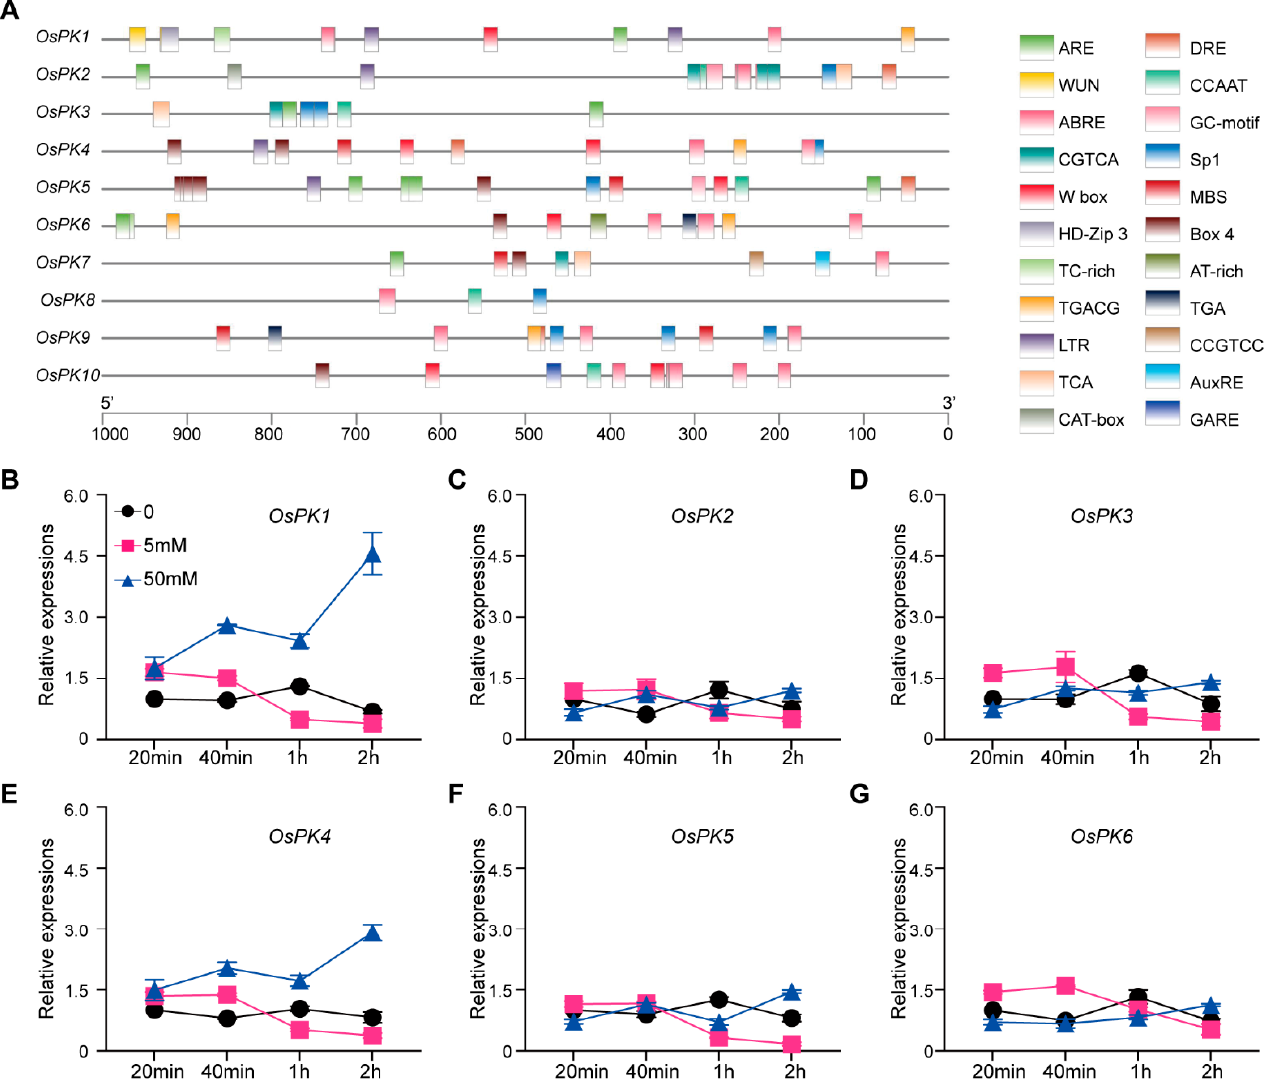
Figure 5. Prediction of promoter element of PK genes in rice and PK gene responses to abscisic ac- id. ( A ) ARE is a cis -acting regulatory element that is essential for anaerobic induction. MBS is an MYB binding site that is involved in drought inducibility. W-box and WUN-motif represent stress- related cis -elements. ABRE is an abscisic-acid-responsive element. CGTCA-motif and TGACG- motif are the cis -acting regulatory elements involved in MeJA responsiveness. LTR is a cis -acting element that is involved in low-temperature responsiveness. Box 4 and Sp 1 are part of a con- served DNA module involved in light responsiveness. AuxRE and TGA are auxin-responsive el- ements. GARE-motif is a gibberellin-responsive element. ( B – J ) The relative expression levels of PK genes ( OsPK1 , OsPK2 , OsPK3 , OsPK4 , OsPK5 , OsPK6 , OsPK8 , OsPK9 , and OsPK10 ) after treatment with ABA. Black lines represent the group without the addition of abscisic acid. Pink lines repre-